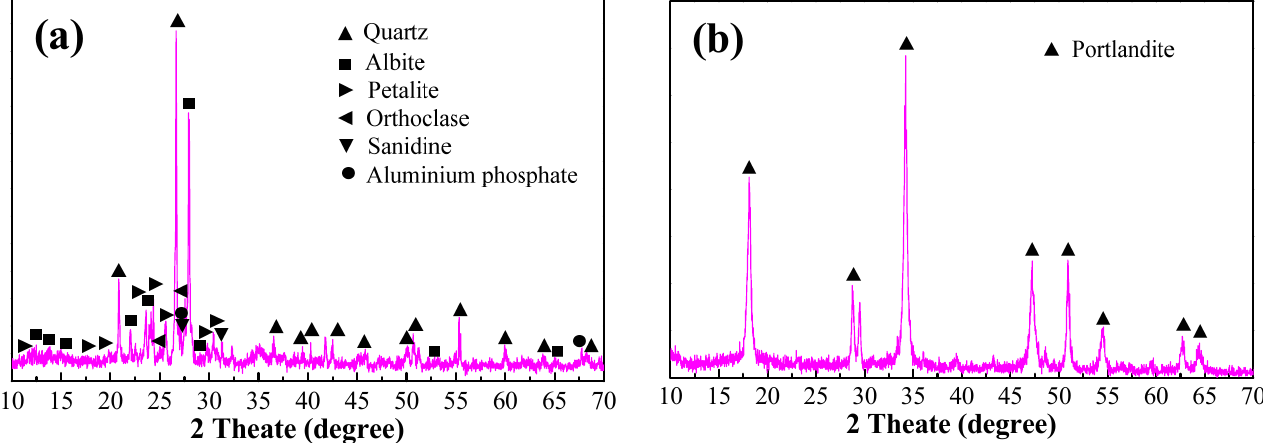
Figure 2. XRD patterns of rock power ( a ) and lime ( b ).